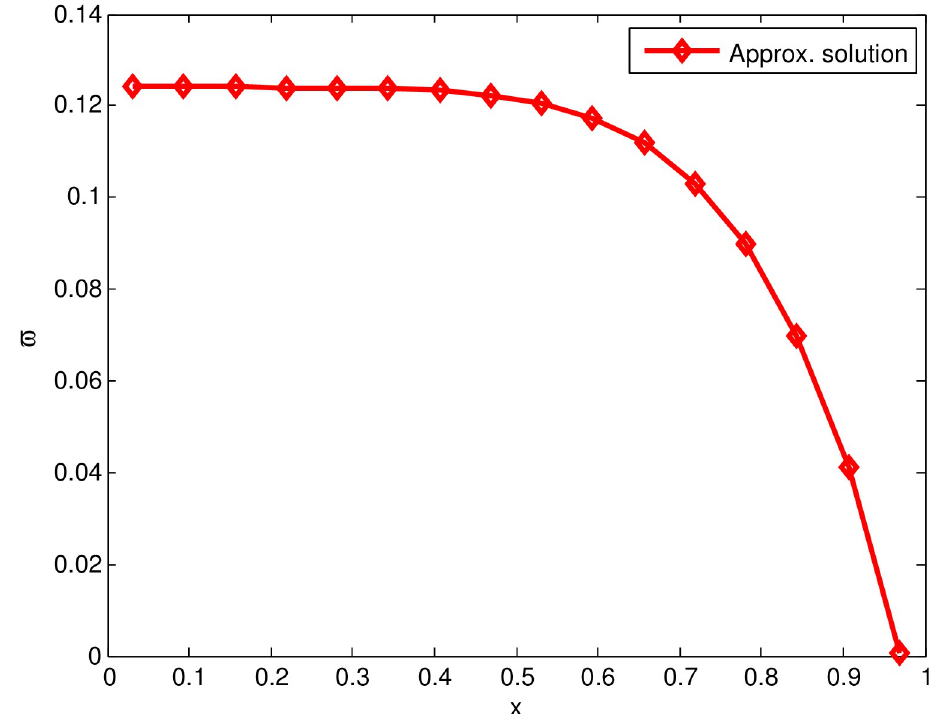
convergence (respectively) at different collocation points for various time step sizes ( Δ t = 10 − 02 , 10 − 03 , 10 − 04 ) and the constant time level t = 1. The obtained MAEs are represent- PWAEs is 10 − 02 along with Δ t = 10 − 02 , b = 0.2, t = 1 and � k ¼ 0 : 35 . Moreover, the order